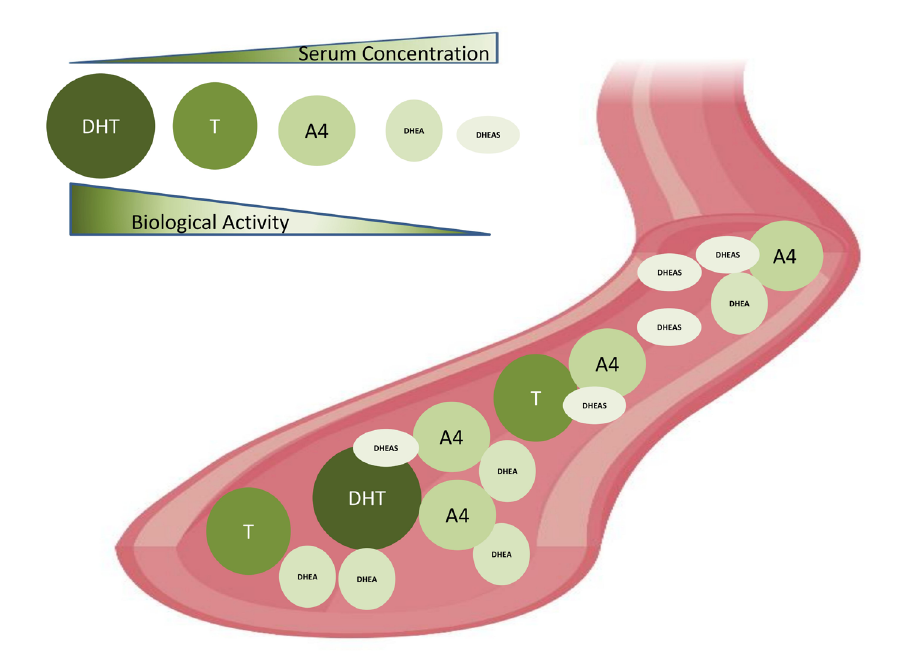
Figure 3. Biological activities and serum concentrations of androgens in women. Serum androgen concentration: DHT < T < A4 < DHEA < DHEAS. Biological activities: DHT > T > A4 > DHEA >